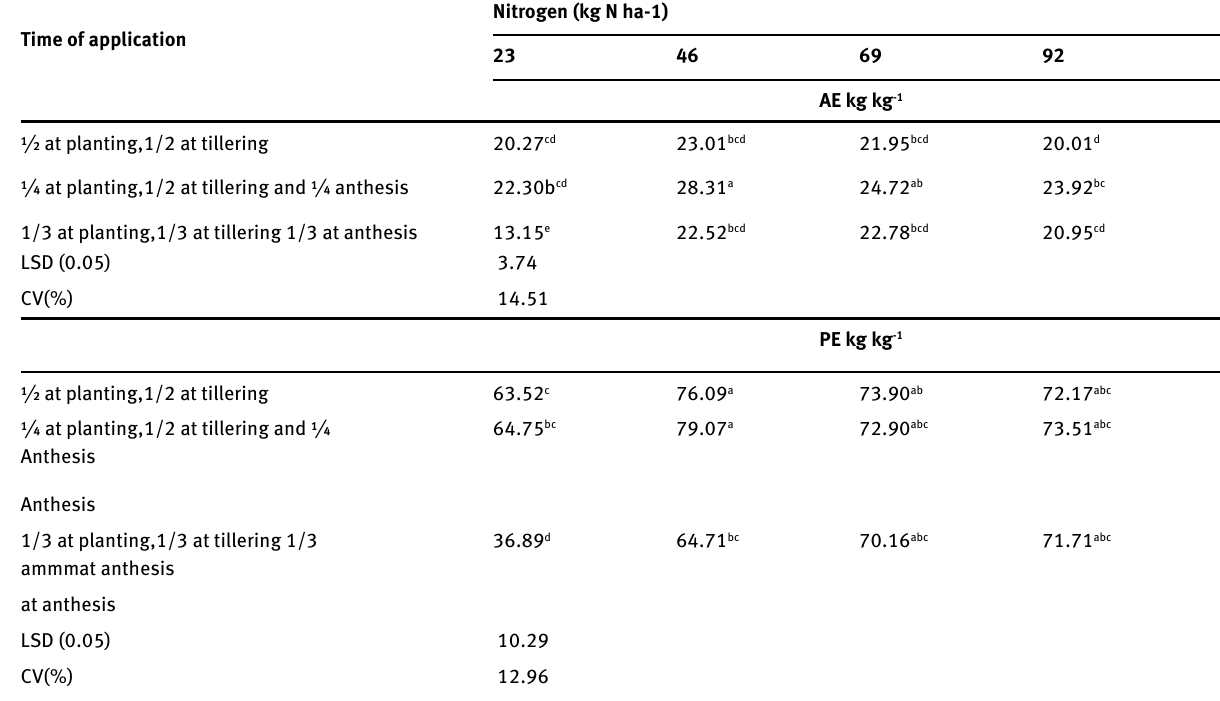
Table 2a: Interaction of nitrogen rate by time of application on agronomic and physiological efficiency of bread wheat in 2013 in Enderta district, Tigray Time of